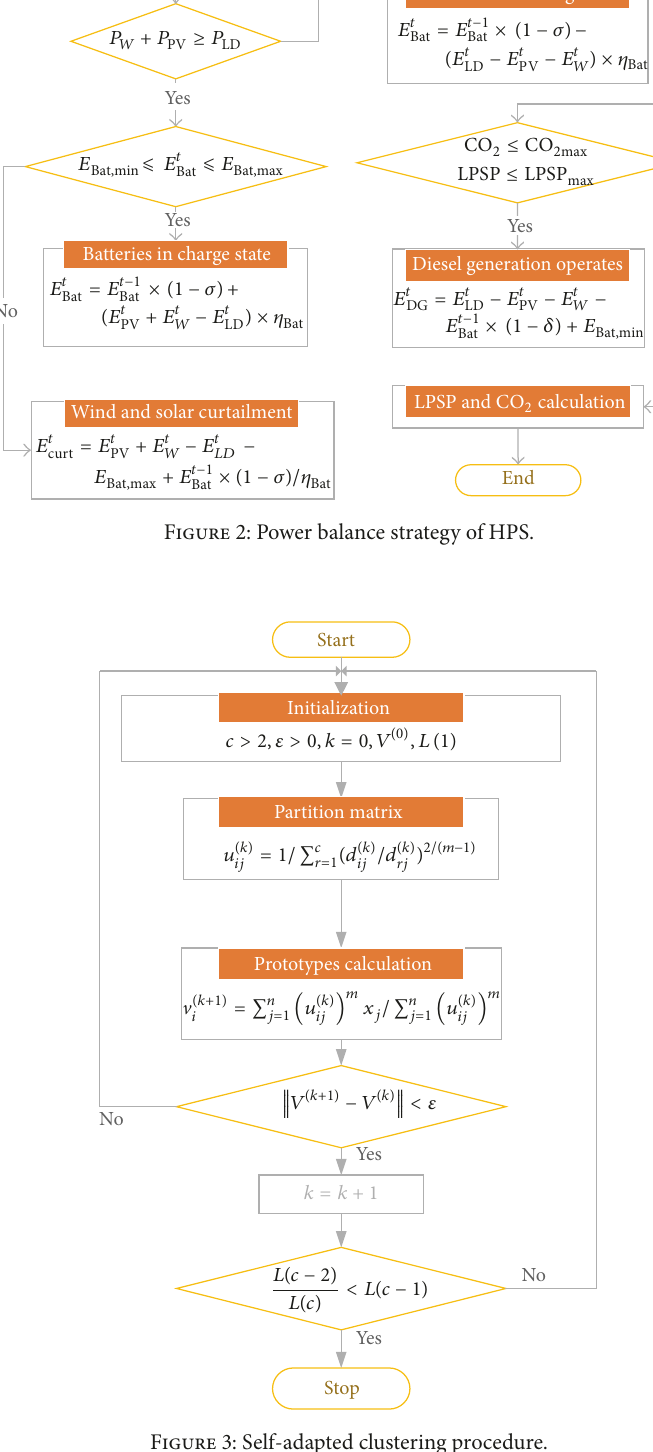
Figure 3: Self-adapted clustering